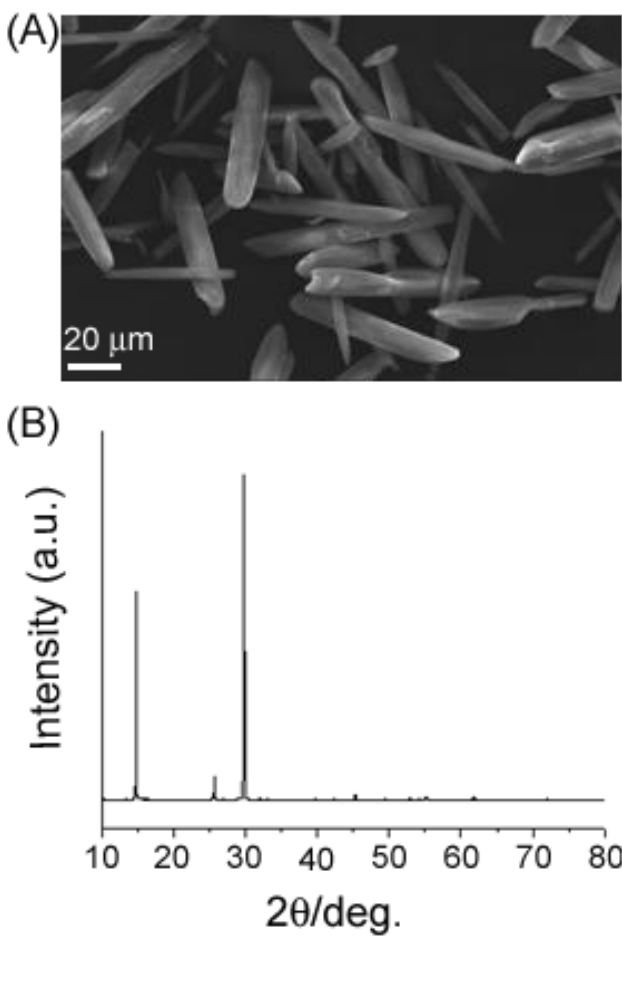
Figure.5. SEM image ( A ) and X-ray powder diffraction (XRD) pattern ( B ) of CaSO whiskers produced using a similar